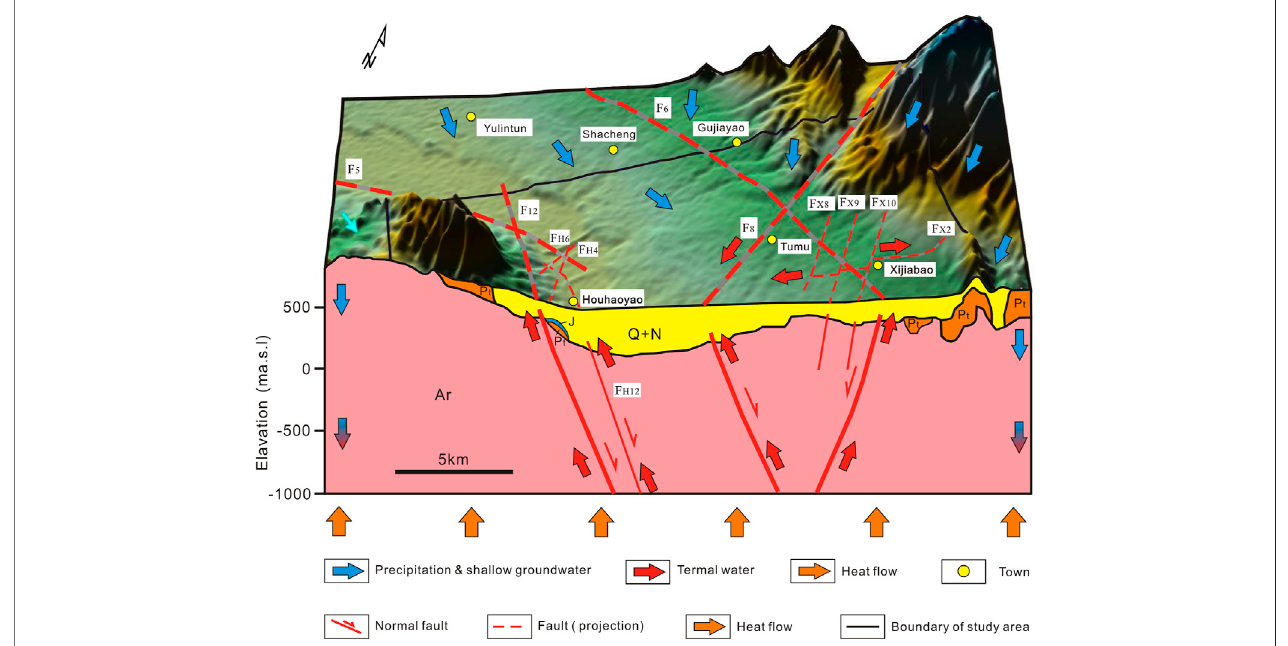
FIGURE 7 | Schematic diagram of genesis model of Houhaoyao and Xijiabao geothermal fi elds.